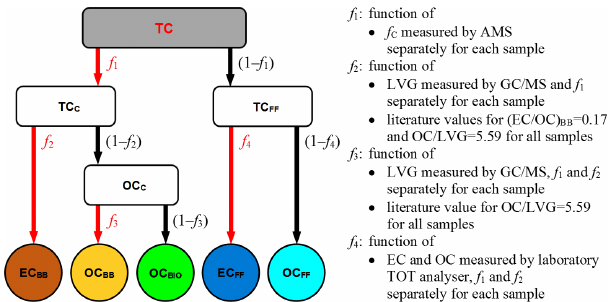
Figure 3. Source apportionment scheme based on the coupled radiocarbon–levoglucosan marker method for the relative contri- butions of EC and OC from fossil fuel (FF) combustion, biomass burning (BB) and biogenic sources (BIO) to the total carbon (TC = EC + OC). The multiplication factors are further explained in the text. The subscript C indicates contemporary carbonaceous fraction. The red arrows specify the input of the primary multipli- cation factors into the apportionment